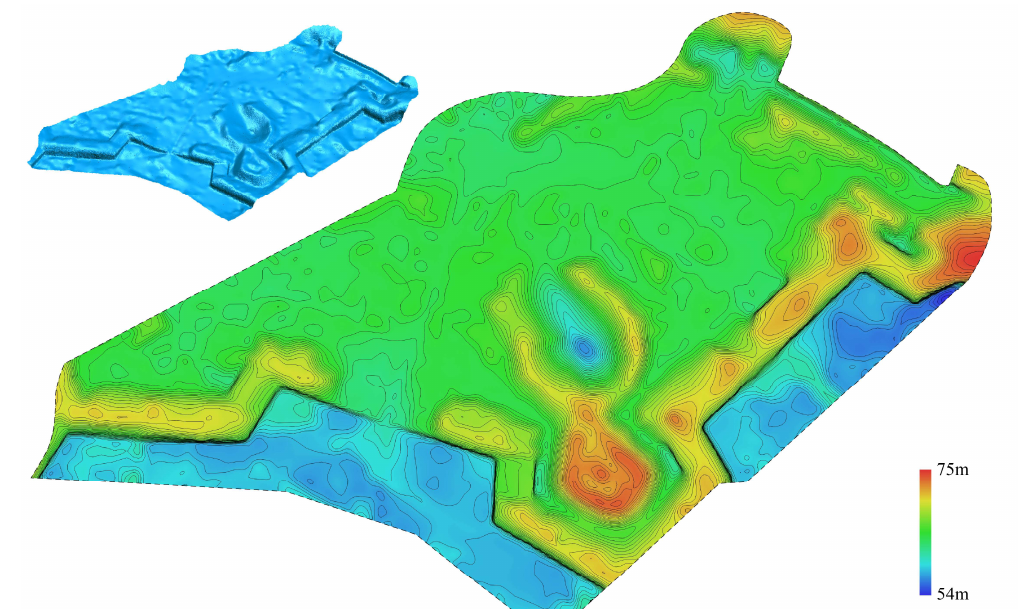
Figure 10. DTM of the Fort of Pietole obtained from the Pegasus Backpack point